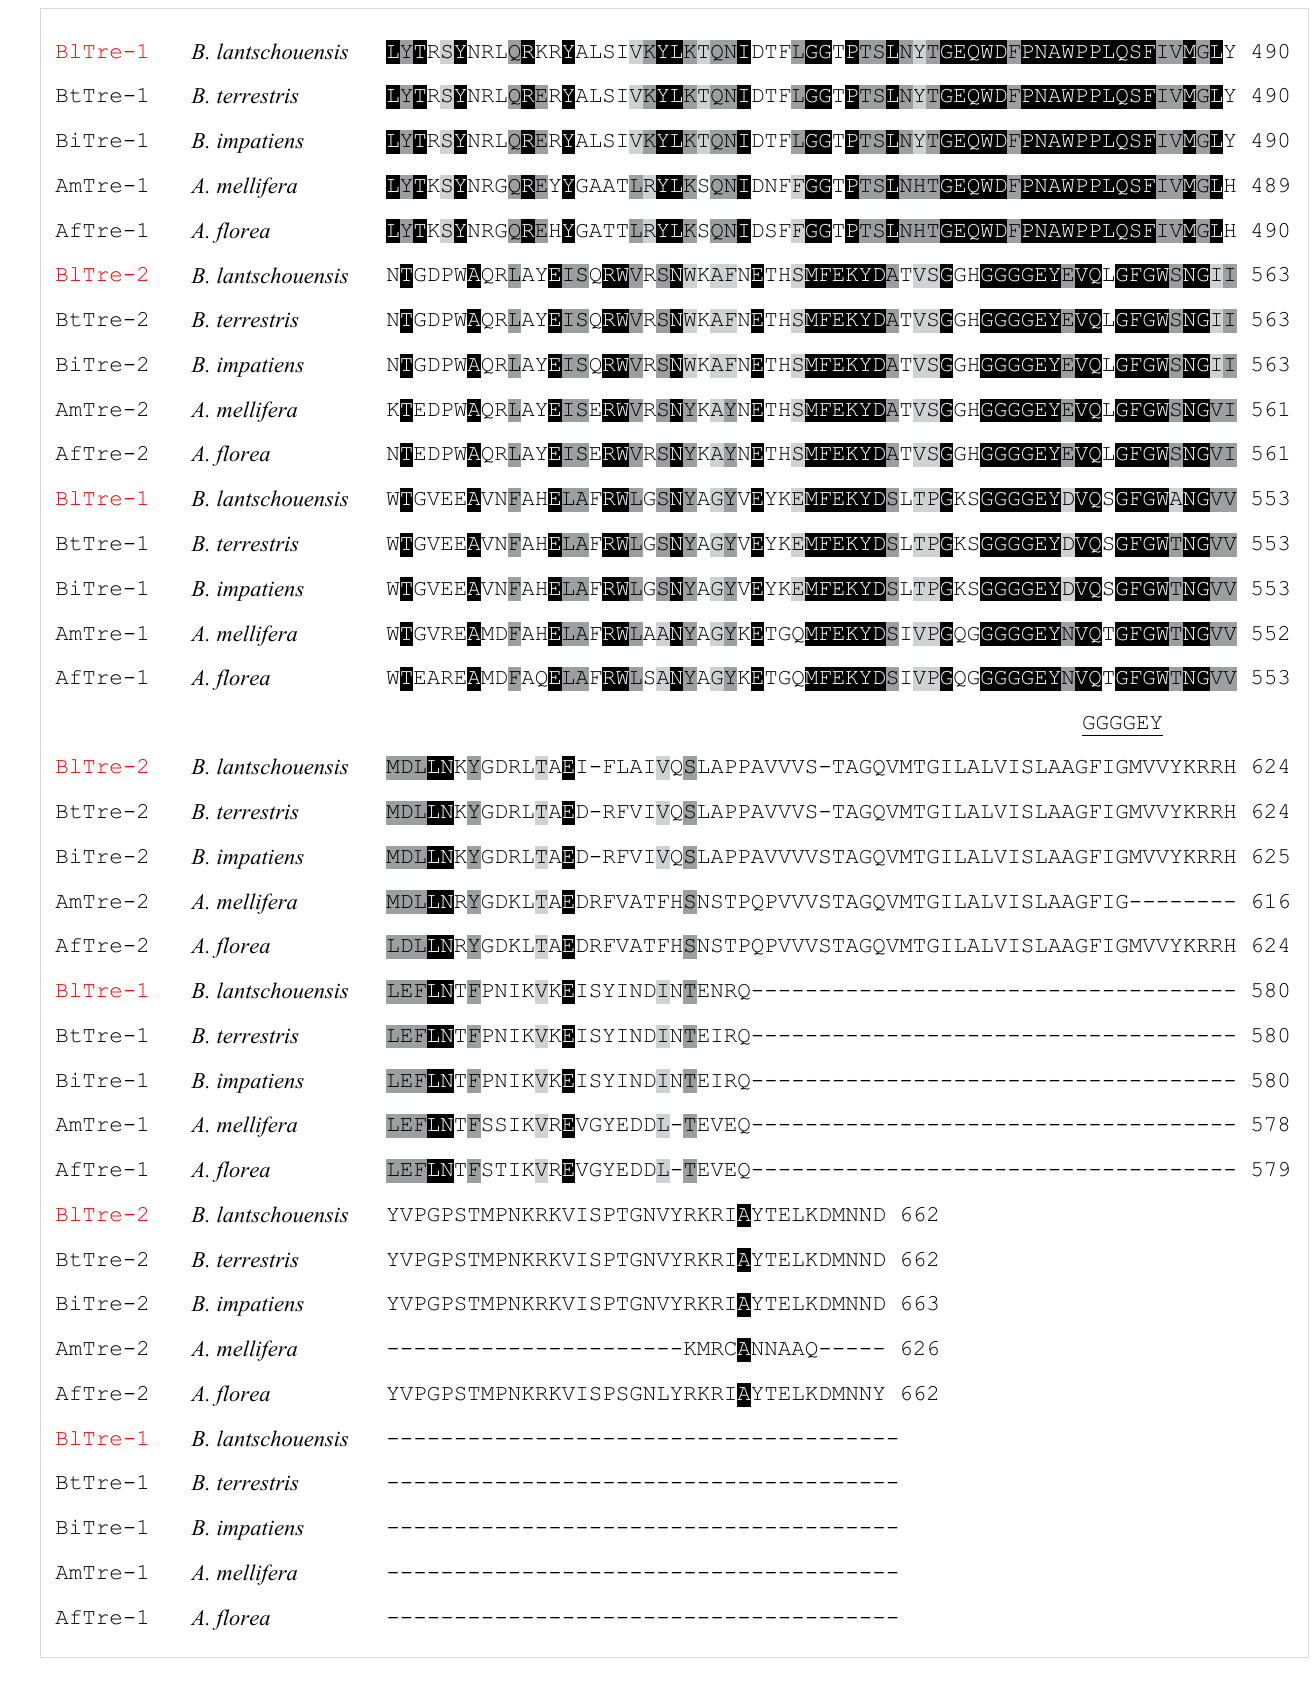
Fig 2 . Comparison of the amino acid sequences of Tre in B. lantschouensis with those in other orthologs.